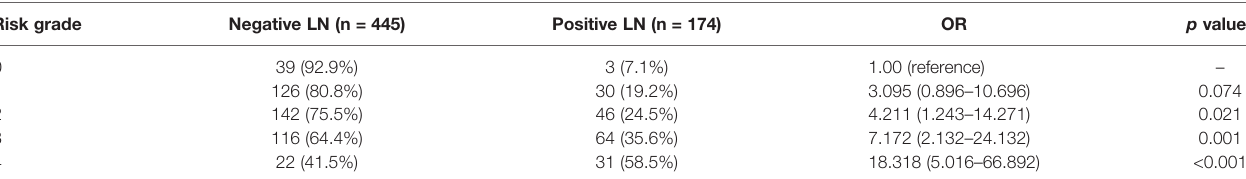
LN, lymph node; OR, odds ratios. a Compared with